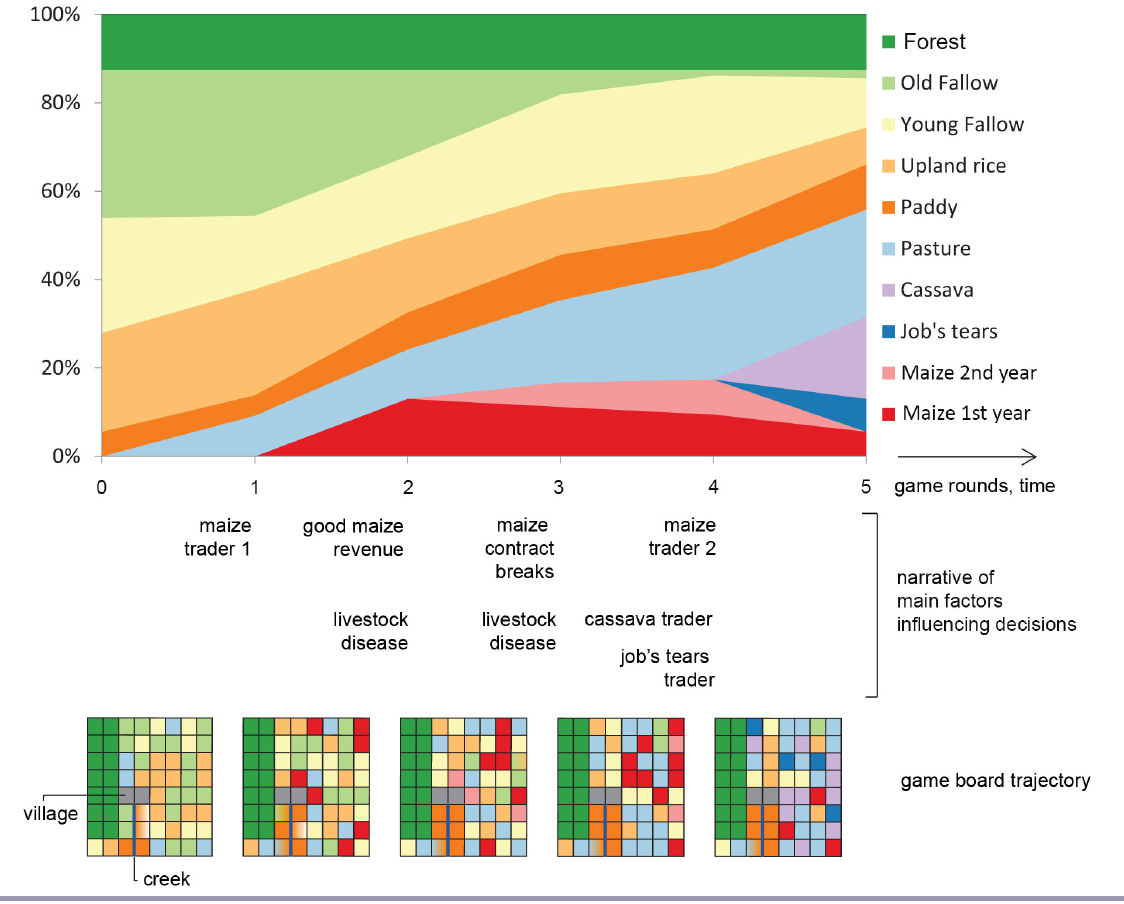
Fig. 5 . Results of the mahasaly metagame session with experts. The top graph shows the cumulative land-use changes of all players, whereas the bottom graph displays the spatial changes on the game board. How game facilitators changed the conditions for all players (e.g., arrival of different traders) is indicated with each round (compare with Fig.